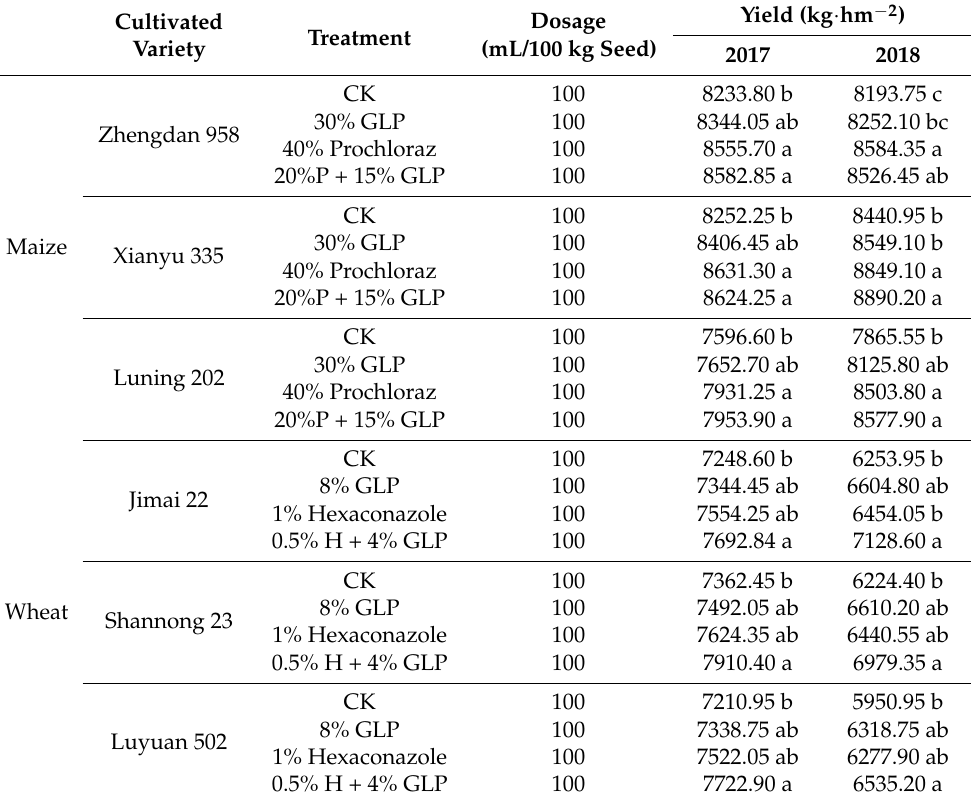
Table 14. Effects of chemical seed treatment on the yield of wheat and